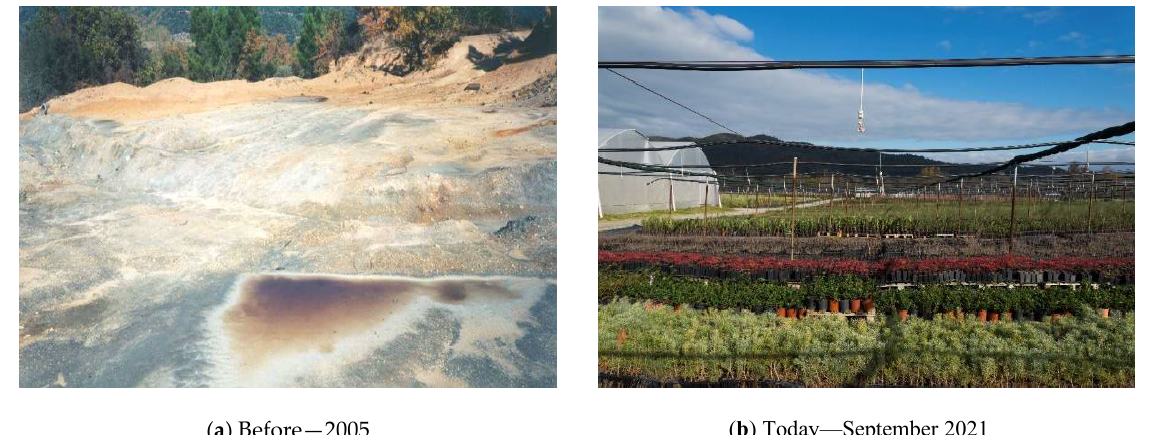
Figure 6. Restoration of the old arsenopyrites concentrate storage area (formerly METBA plot).